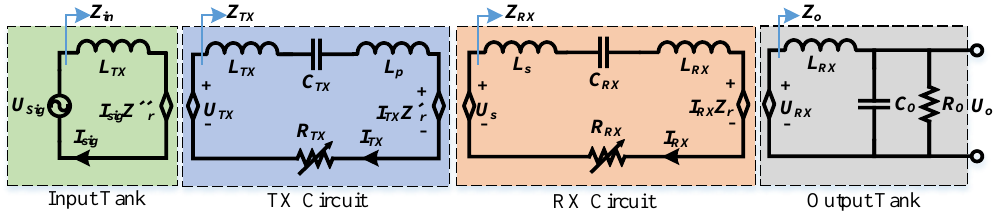
Figure 5. Equivalent circuit of the data channel in forward direction.